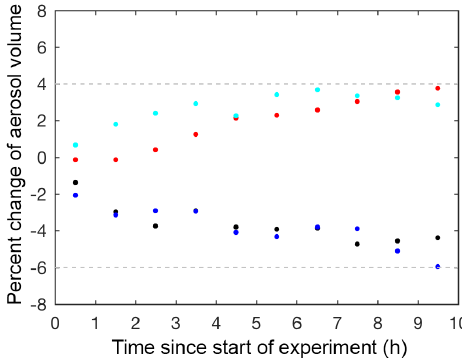
Figure 3. Percent change between the corrected aerosol volume over 10h and the corrected aerosol volume at the start of pho- tooxidation (60min averages) for the following particle wall depo- sition control experiments: C1 ( V = 37µm 3 cm − 3 ; black dot), C2 ( V = 109µm 3 cm − 3 ; blue dot), C3 ( V = 183µm 3 cm − 3 ; red dot), and C4 ( V = 375µm 3 cm − 3 ; cyan dot), where V is the initial cor- rected particle